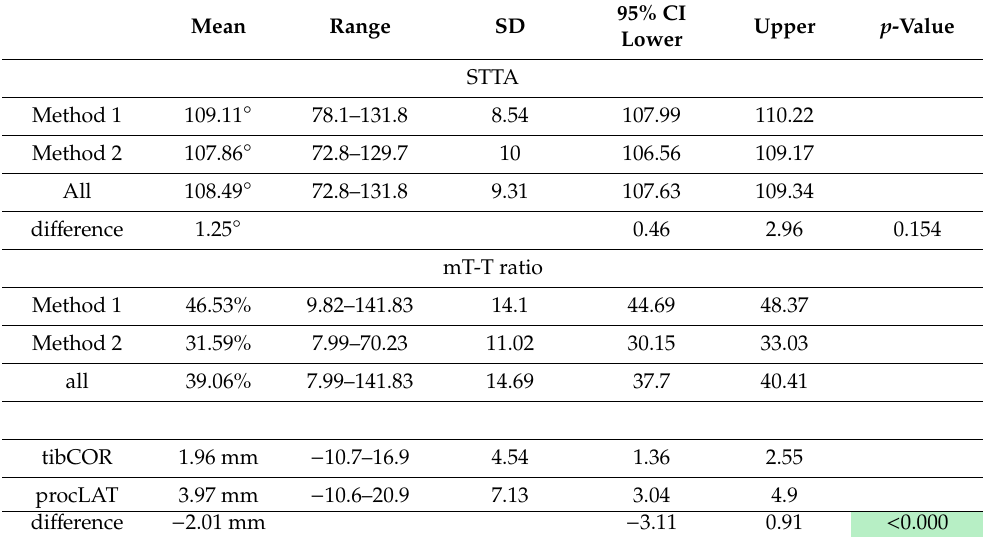
Table 2. Radiographic